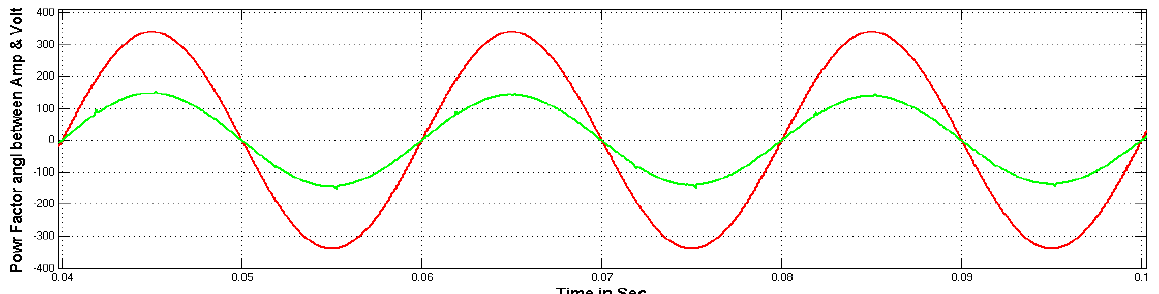
Figure 12. Source current and voltage phase angle